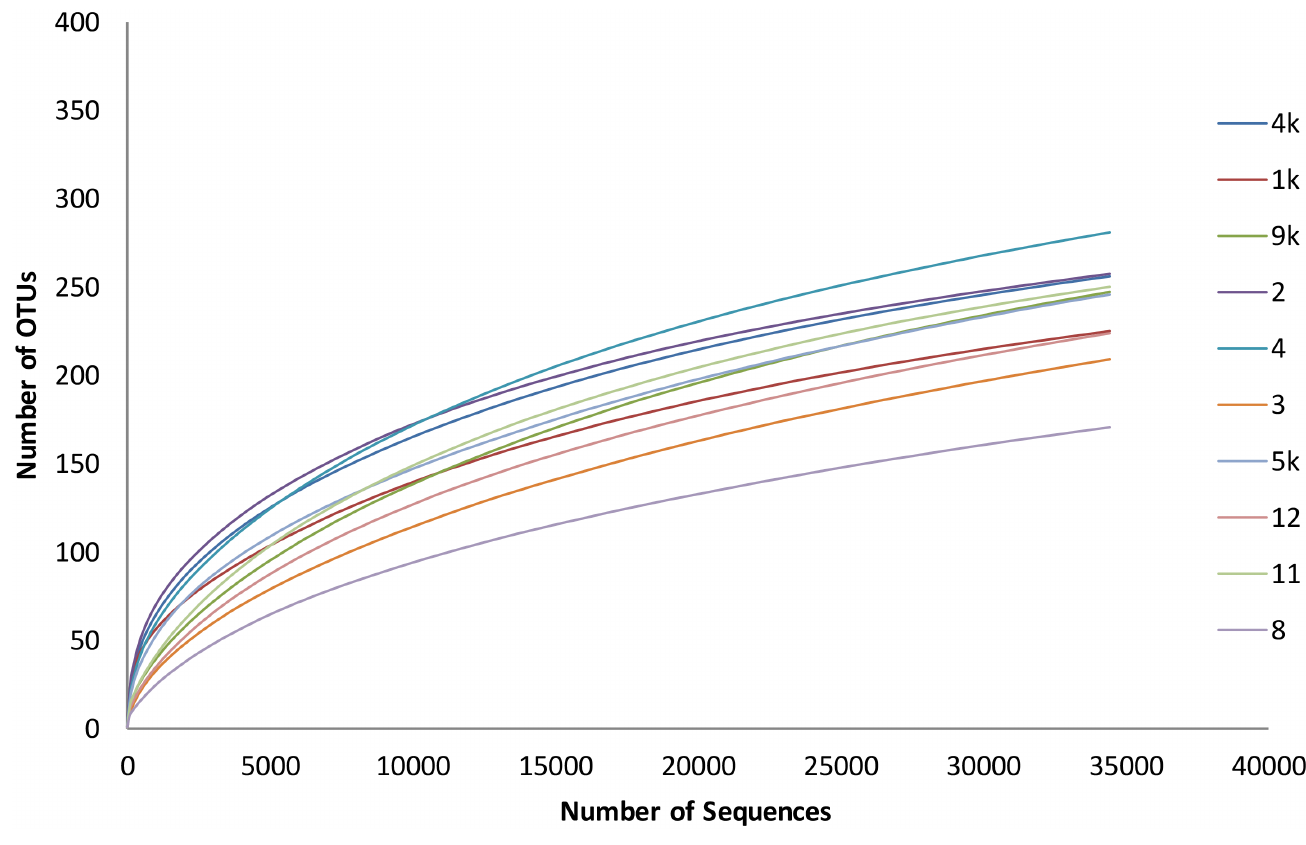
Fig 6. Rafefaction curve of the 10 deep caries samples.